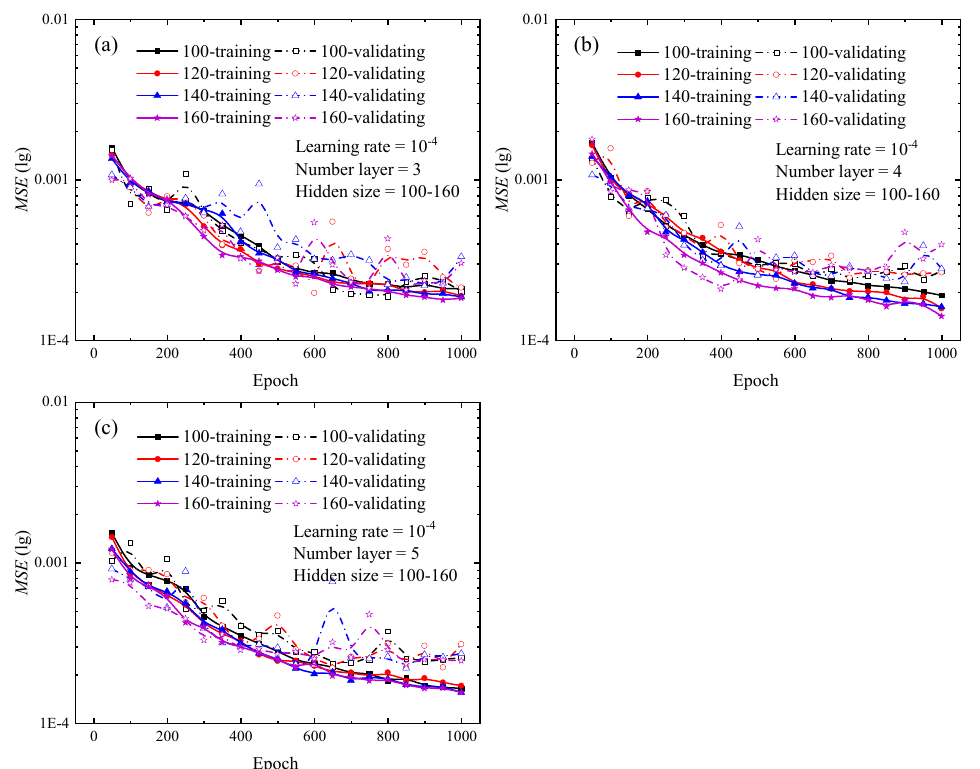
Figure 6. Loss curves of different hidden sizes during the training and validating phrases for indentation predictions. ( a ) The number of hidden layers is 3; ( b ) The number of hidden layers is 4; ( c ) The number of hidden layers is 5. In the legend, the cases of 100, 120, 140 and 160 represent the number of hidden sizes the LSTM neural network.